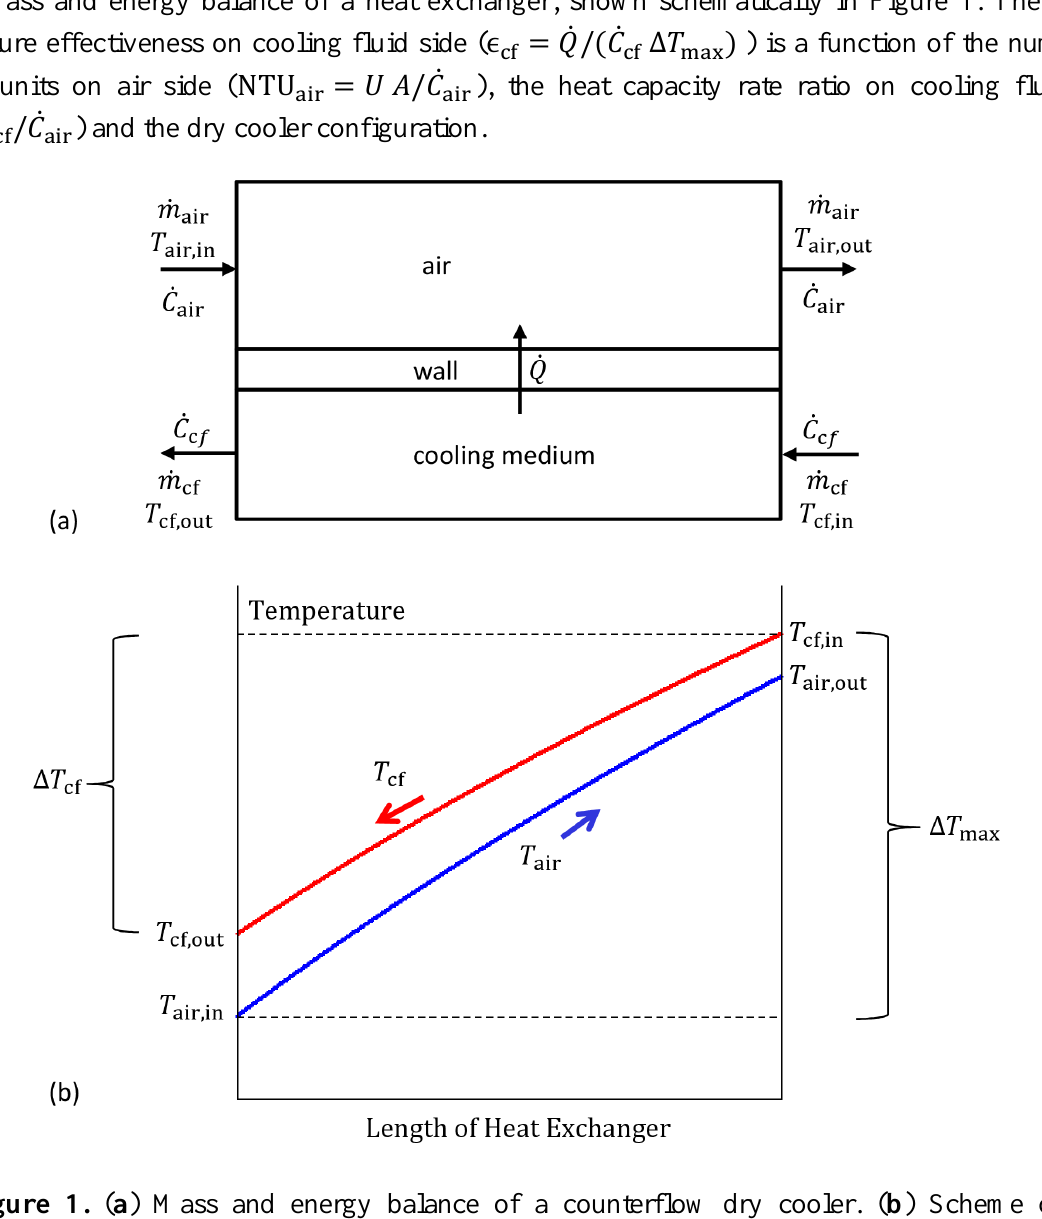
is defined cf due to the energy = Δ𝑇 /Δ𝑇 cf cf max